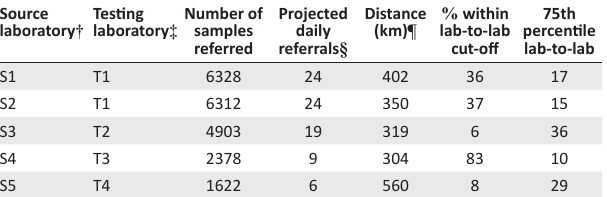
FIGURE 2: Relationship between inter-laboratory CD4 testing referral distance and travel time between source and CD4 testing laboratories in the 2018 calendar year across the National Health Laboratory Services in South Africa.